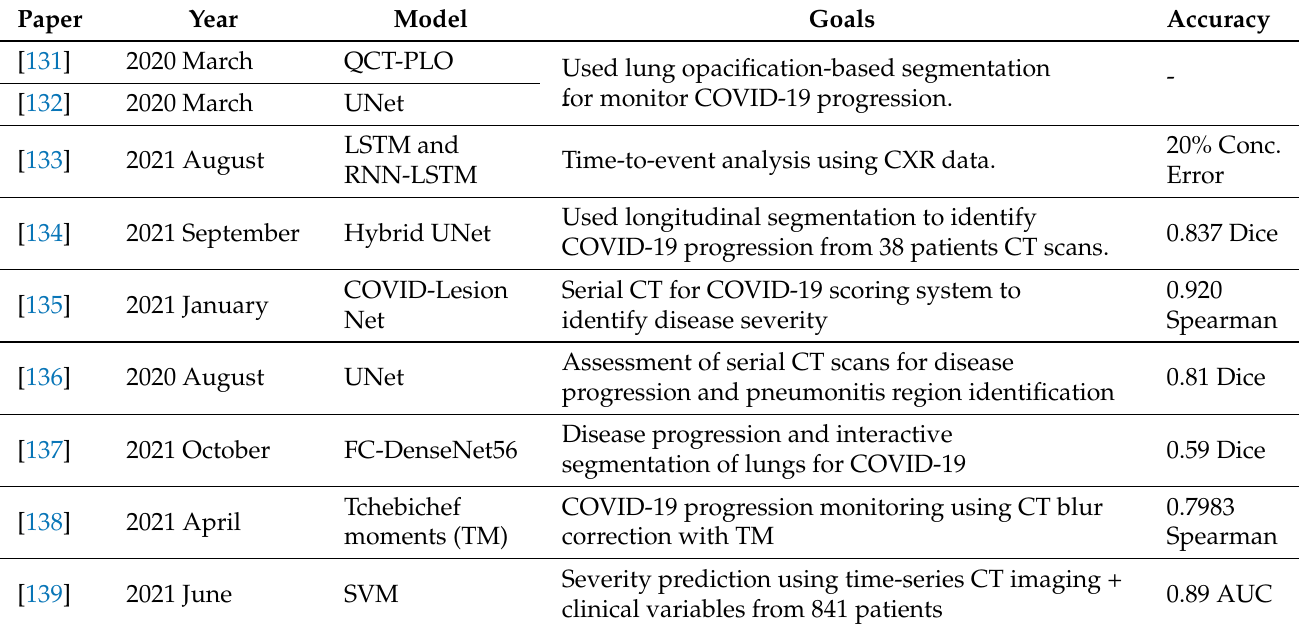
Table 6. Machine learning approach summarized for developing longitudinal models in